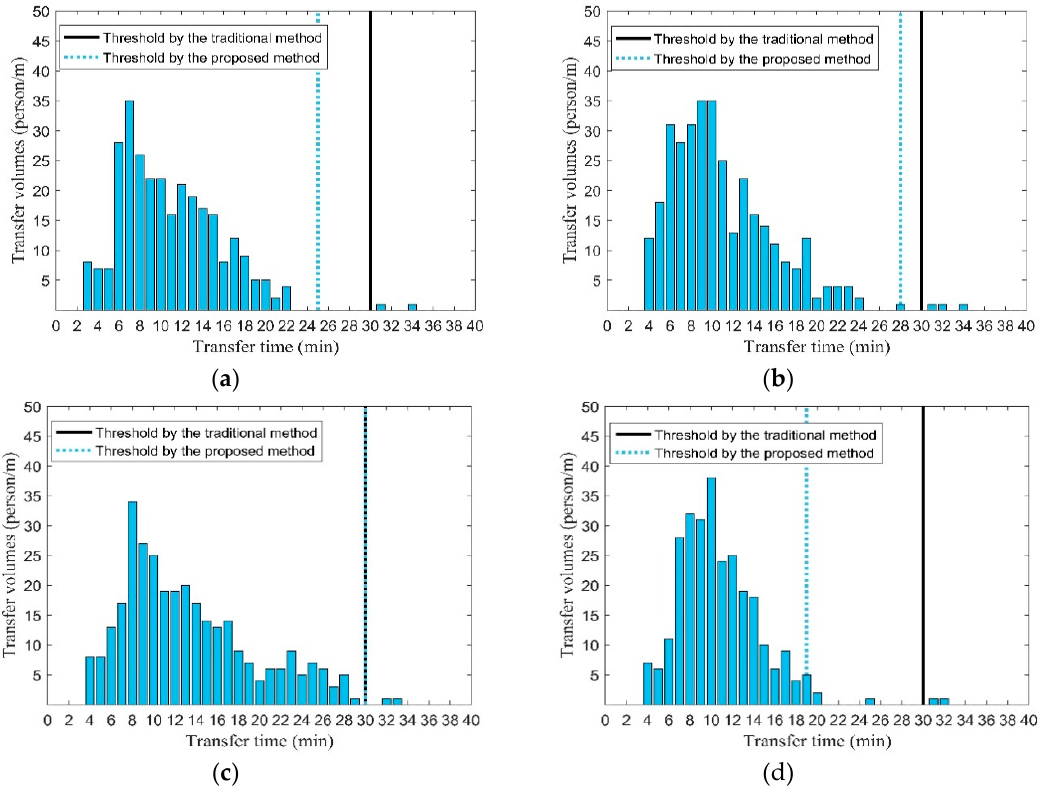
Figure 8. Comparison of two metro-to-bus transfer identification methods at four stations at 7:00–9:00 on 21–22 March. ( a ) Guomao station. ( b ) Shenzhen university station. ( c ) Daxin station. ( d ) Airport east station. Table 3. Statistical comparisons the di ff erent